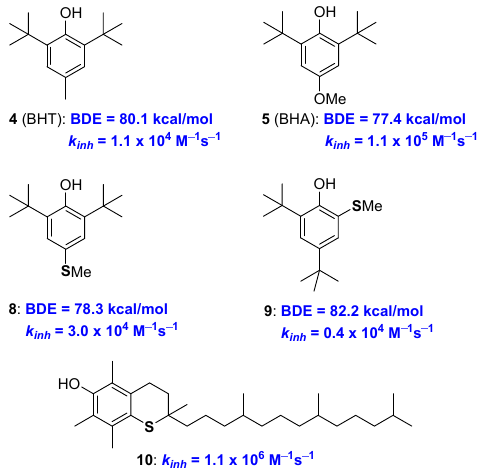
Figure 5. Performances of Sulfur analogues of BHA 8, 9 and all rac -1-thio- α -tocopherol 10.